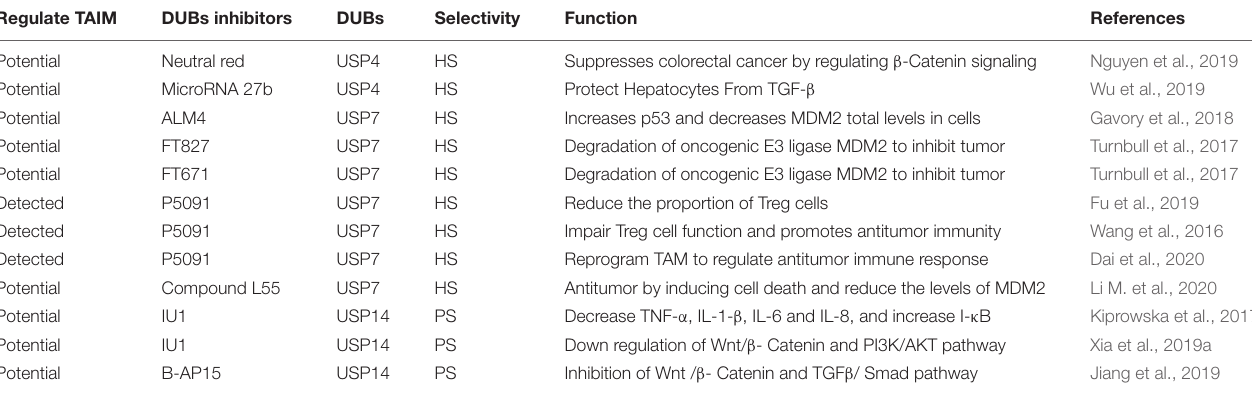
TABLE 2 | Related research on inhibitors of DUBs that regulate